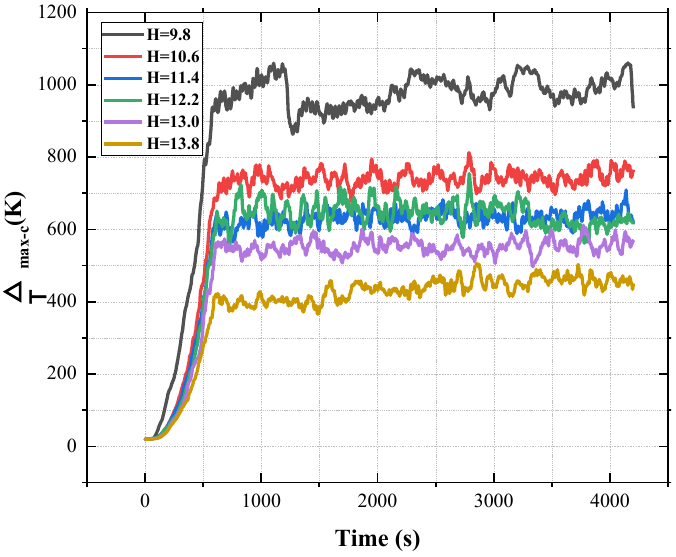
Figure 4. The maximum excess temperature versus time beneath the ceiling.